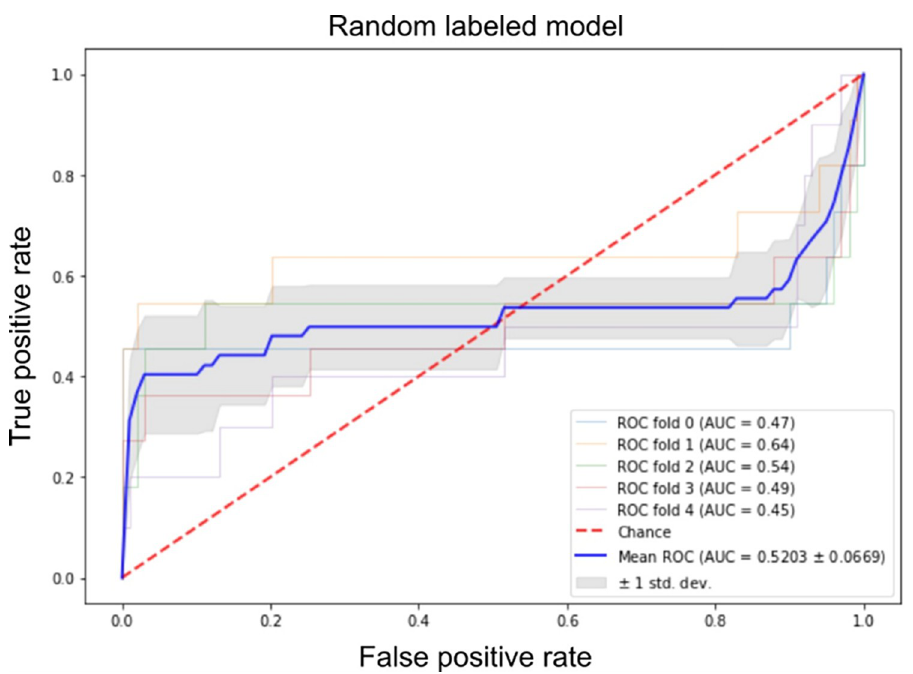
Fig 7. ROC and AUC analysis for a randomized version of the proposed model.